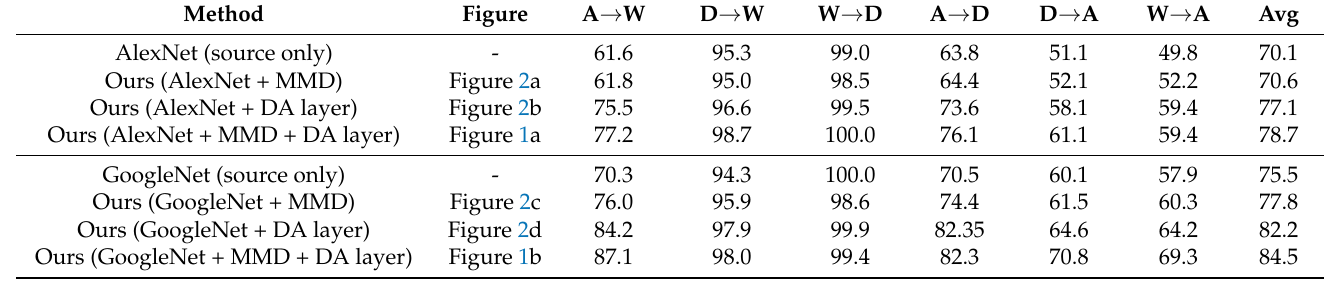
Table 4. Ablation study: classification accuracy (%) of the Office-31 dataset for unsupervised domain adaptation (AlexNet and GoogLeNet).